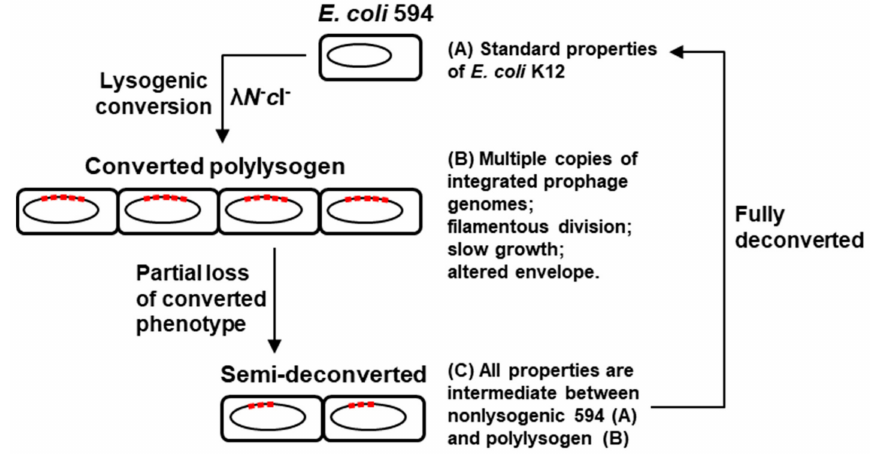
Figure 12. Schematic model of polylysogenic conversion and spontaneous deconversion, summarizing the key results reported in this